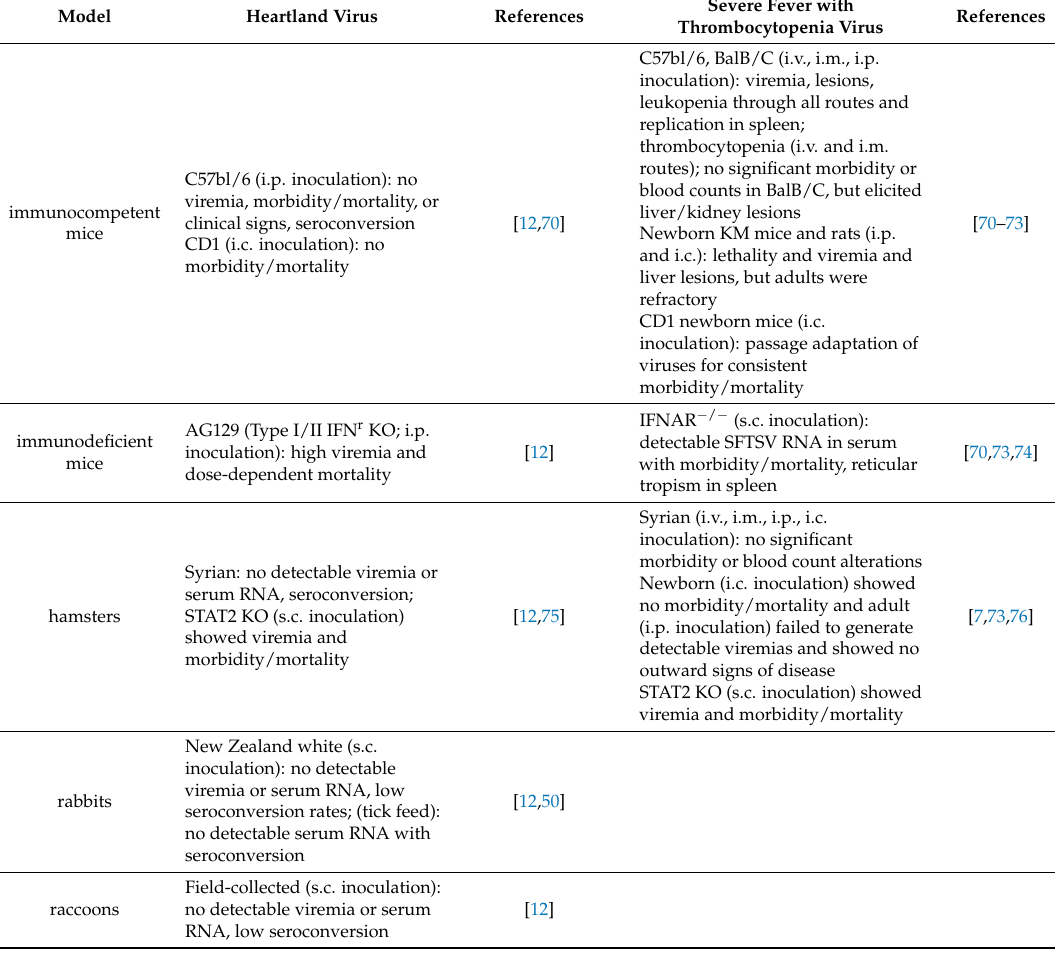
Table 1. Animal models assessed for Heartland virus (HRTV) and severe fever with thrombocytopenia syndrome virus